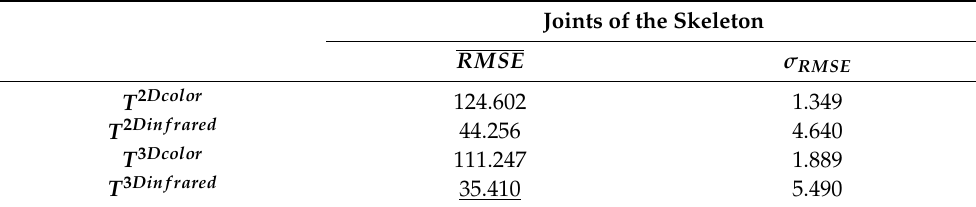
Table 3. Average and standard deviation of the RMSEs calculated between aligned and reference skeletal joints, where calibration techniques have been applied [mm]. The best result of RMSE is